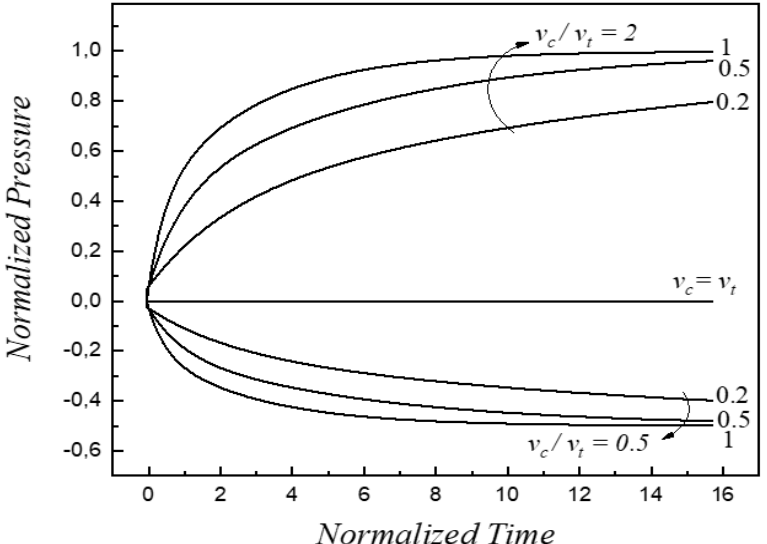
Figure 1. Theoretical simulation of the time evolution of the pressure P, normalized by K, using Equations (1) and (2), for different normalized pump intensities, i.e., in units of I = I A φ tc σ t : 0.2, 0.5, and 1.0, and for different ratios of the occupied volumes of the isomers: v c / v t = 0.5, 1.0, 2.0. Note that when v c / v t = 1, no pressure occurs, i.e., no isomeric volume change. Negative (positive) pressure occurs for v c / v t < 1 ( v c / v t > 1 ) and the larger the pump intensity, the faster the pressure build-up.